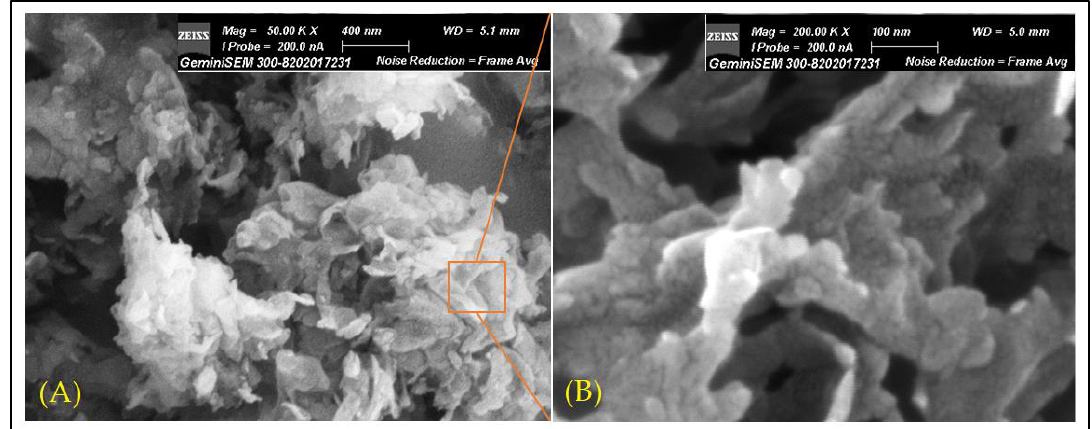
Figure 7. FESEM image for g-C 3 N 4 at magnifications of 400 nm ( A ) and 100 ( B ).